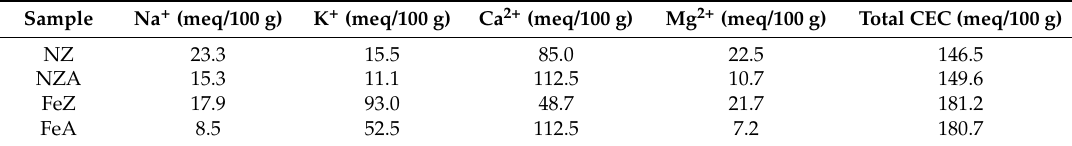
Table 2. Determination of the cation exchange capacity (CEC) for NZA and FeA.